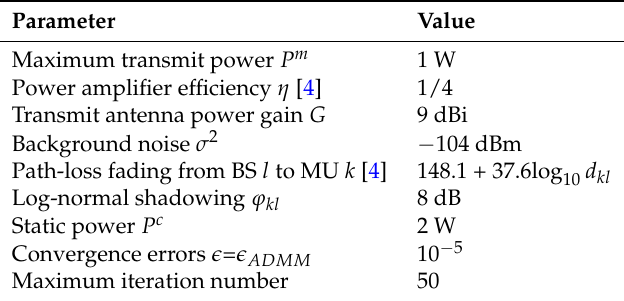
Figure 1. Simulation setup in a downlink C-RAN. Table 1. Simulation parameters.